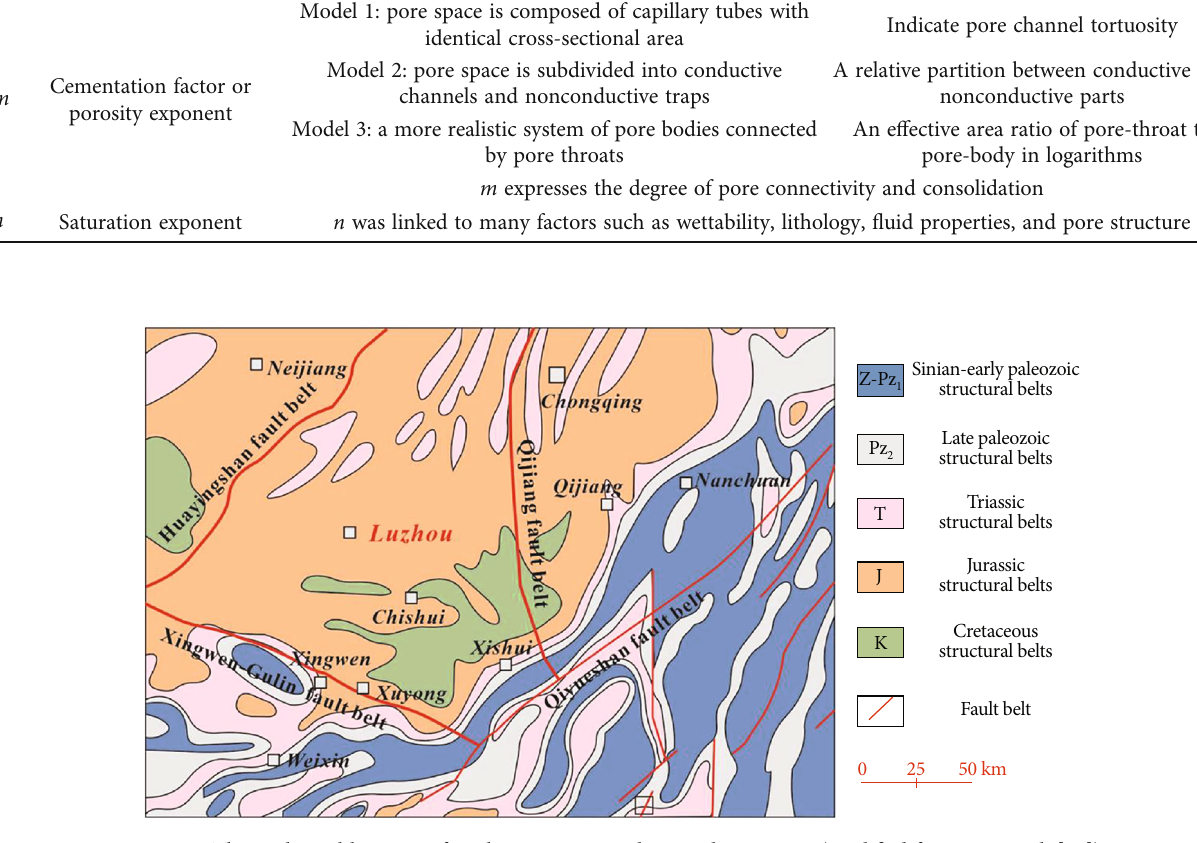
Figure 1: The geological location of Luzhou area in Southern Sichuan Basin (modi fi ed from Pan et al.